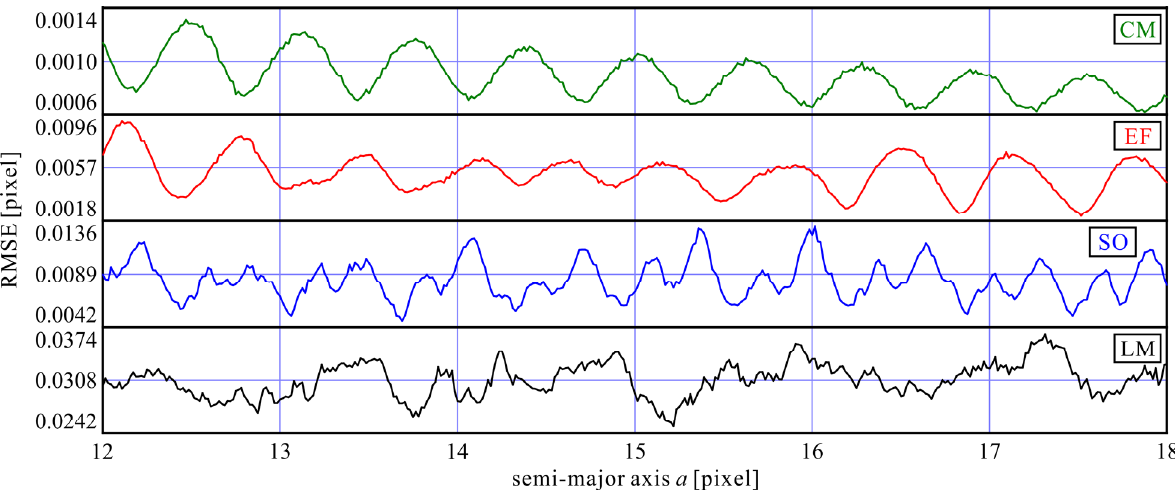
Figure 10. RMSE of the center location measurement of an ellipse (12 pixels  a  18 pixels, f = 0.50,  =